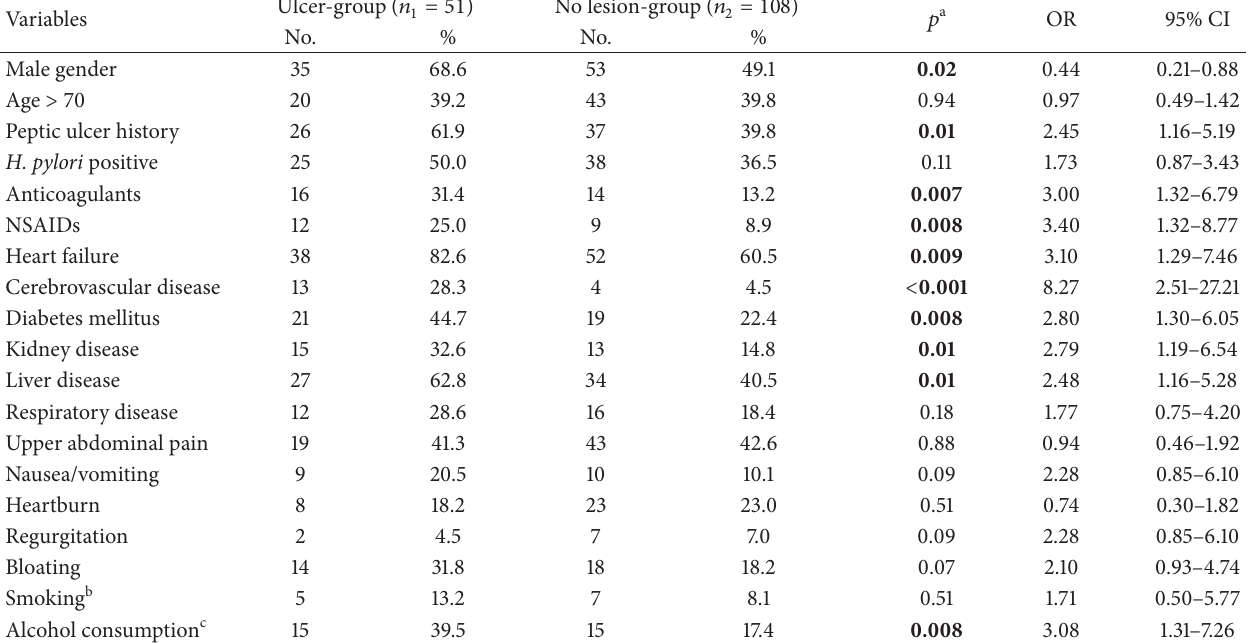
Table 1: Group differences regarding studied factors in patients treated with low-dose